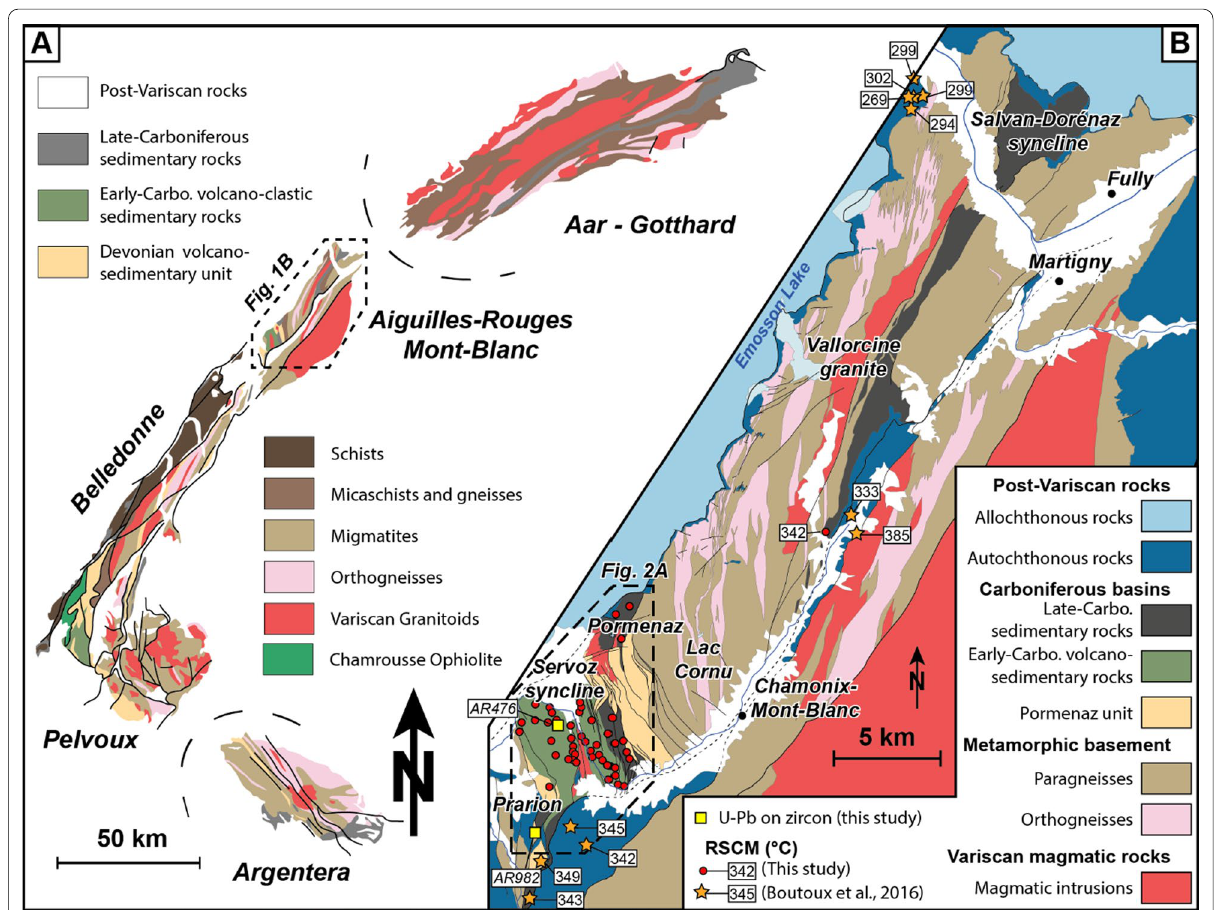
Fig. 1 A Geological map of the Variscan basement of the External Crystalline Massifs. B Geological map of the Aiguilles‑Rouges massif with locations of LA‑ICPMS U–Pb zircon dated samples AR476 and AR982, and RSCM samples analysed in this study and Boutoux et al. (2016). Location of Fig. 2A is